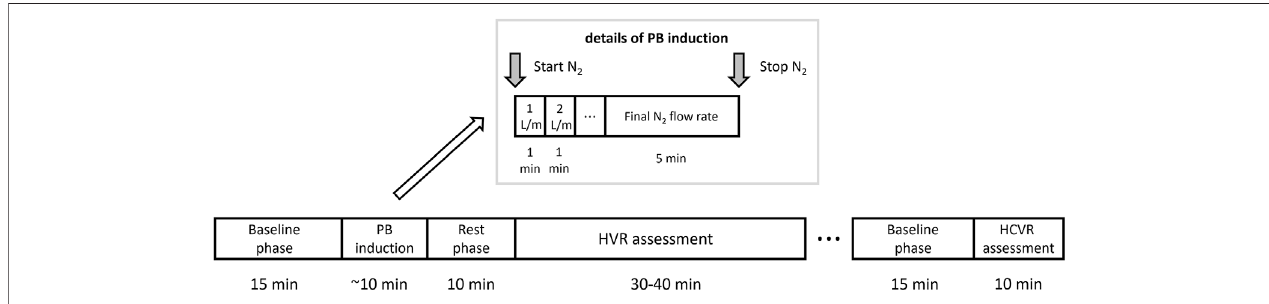
FIGURE 1 | Study protocol. A graphical depiction of the timeline and details of the periodic breathing (PB) induction, hypoxic ventilatory response (HVR) and hypercapnic ventilatory response (HCVR)